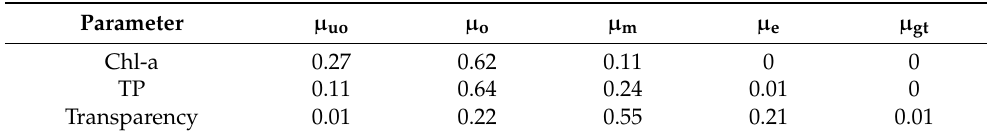
Table 3. Probabilities of the trophic status of the Lake Baikal littoral zone by mean values Chl-a, TP and